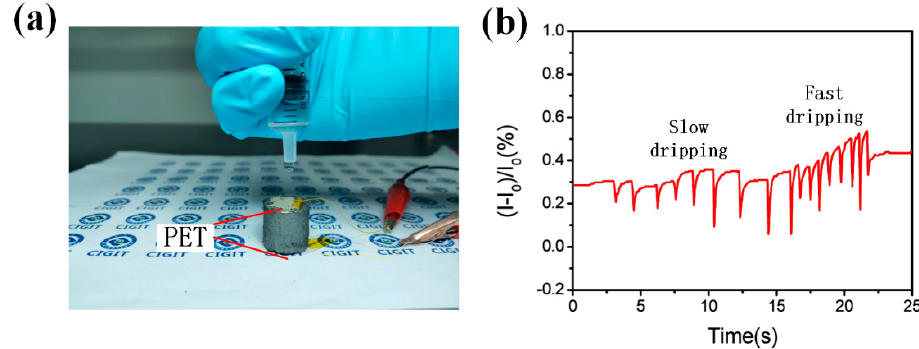
Figure 6. ( a ) The test of dripping water droplets on the GSBF sensor. ( b ) The curve of water-dripping test.